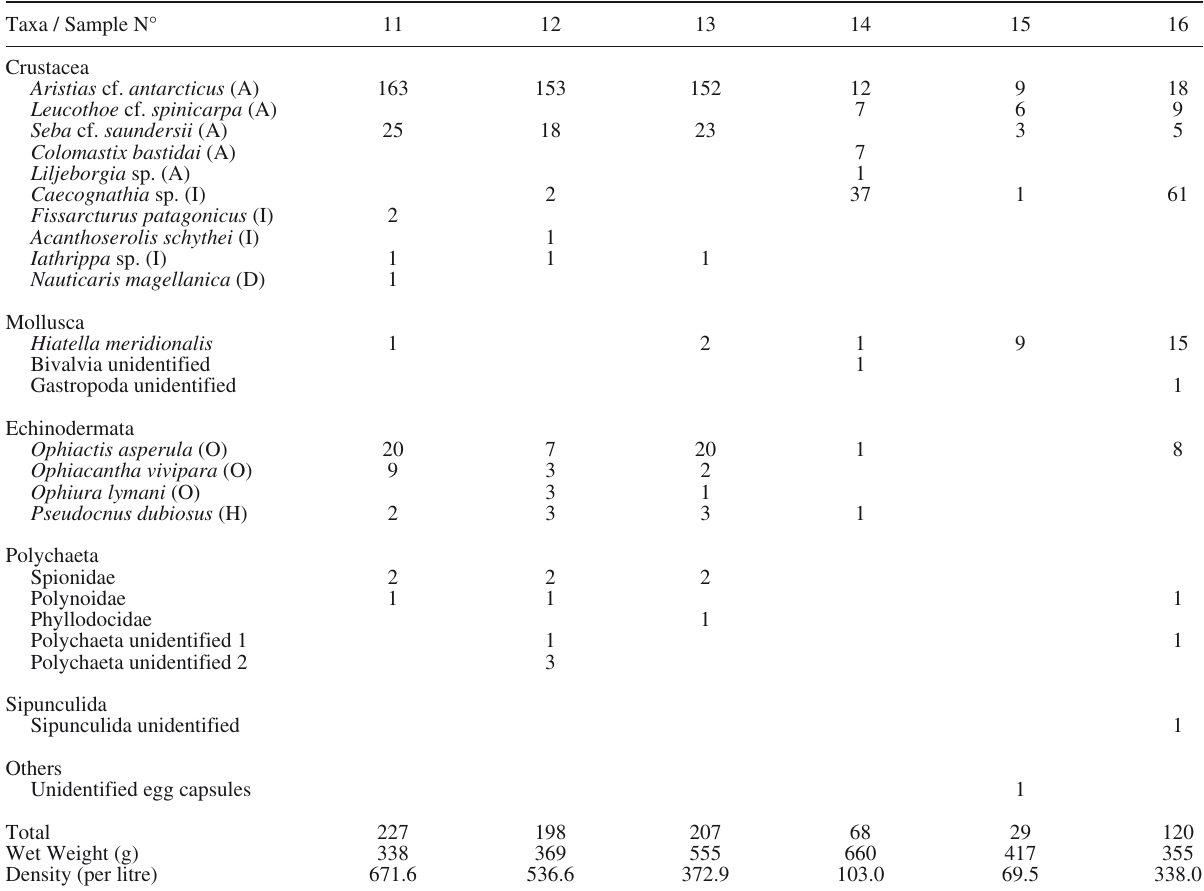
Table 2. – Taxa and number of individuals associated with Mycale ( Aegogropila ) magellanica (Ridley, 1881) in the studied frozen samples. Location for each sample is given in Table 1. (A) Amphipoda, (I) Isopoda, (D) Decapoda, (O) Ophiuroidea, (H) Holothuroidea. Taxa / Sample N° Crustacea Aristias cf. antarcticus (A)